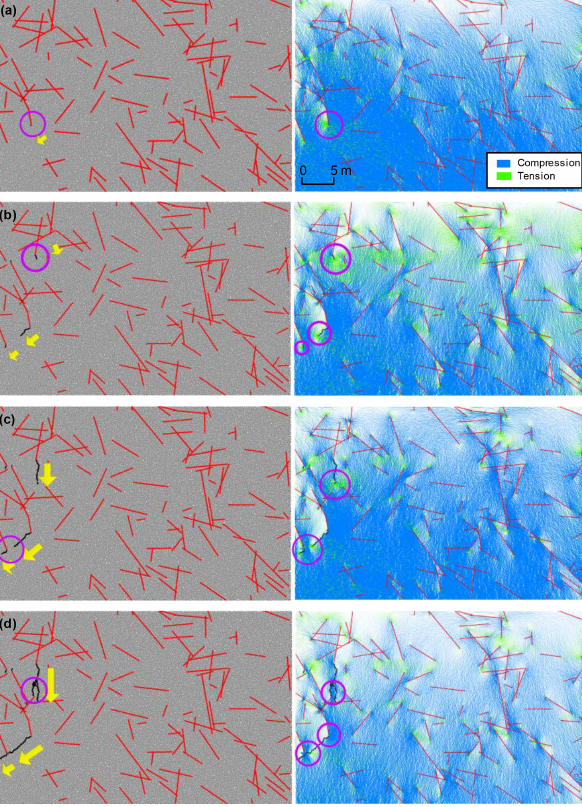
Figure 8. Formation process of the critical slip surface (drawings on the left) and force chain plots (drawings on the right). The time steps of (a)–(d) are 2 × 10 3 , 5 × 10 3 , 10 4 , and 2 × 10 4 .